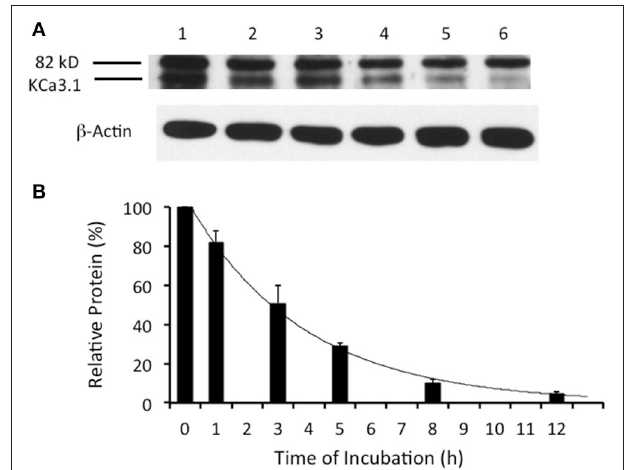
FIGURE 2 | Degradation time course of membrane labeled KCa3.1-BLAP channels. Time course of KCa3.1 was investigated over a 12 h period. (A) After basolateral streptavidin labeling, cells were further incubated in 37 ◦ C for 0 (no incubation), 1, 3, 5, 8, or 12 h before being lysed and detection of KCa3.1 via immunoblot. Lane 1: Control no incubation ( t = 0), Lane 2: 1 h of incubation ( t = 1), Lane 3: 3 h of incubation ( t = 3), Lane 4: 5 h of incubation ( t = 5), Lane 5: 8 h of incubation ( t = 8), and Lane 6: 12 h of incubation ( t = 12) (B) Immunoblot results were quantified by densitometry. Relative protein expression demonstrated that the half-life of KCa3.1 was ∼ 3 h with only 5% of the labeled channels remaining at 12 h. Each lane was loaded with 30 µ g of protein and β -actin was used as a loading control ( n =